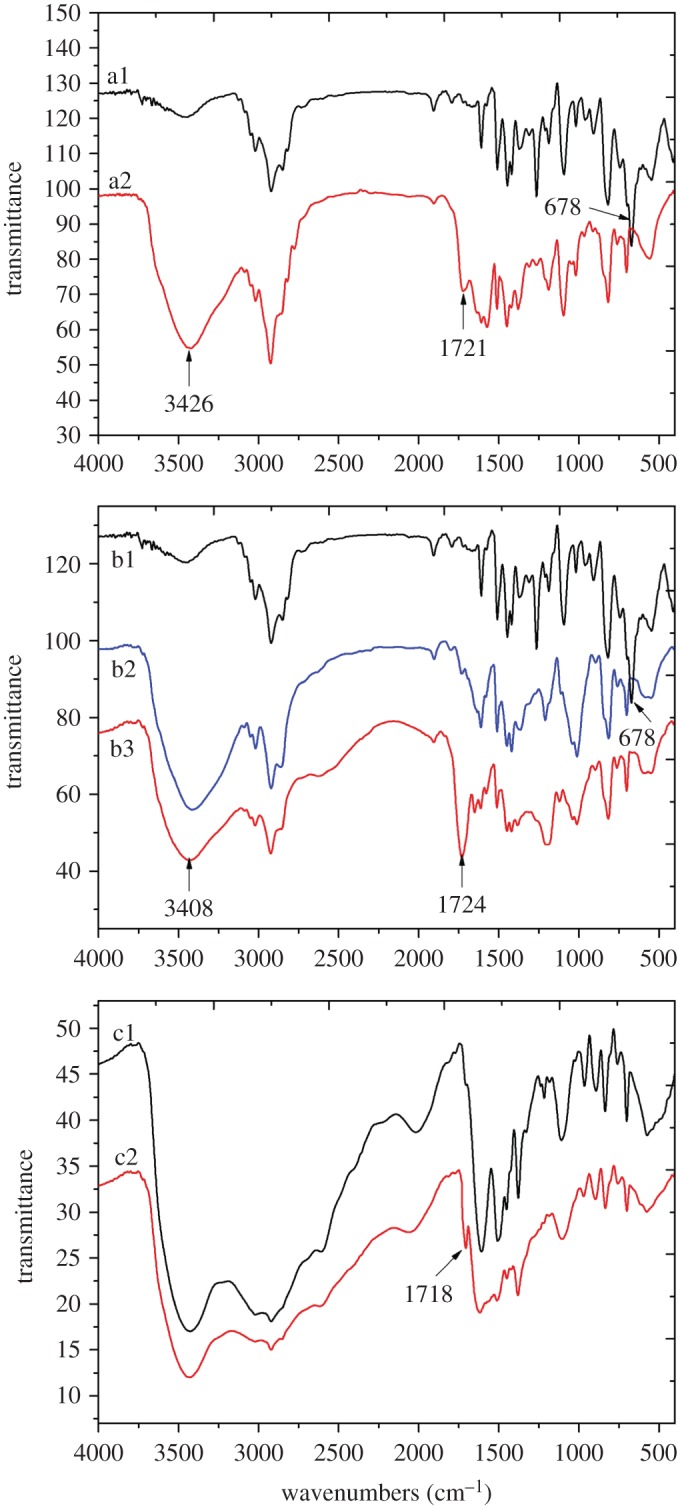
The FTIR spectra of PS-Cl (a1, b1), PS-CA (a2), PS-OH (b2), PS-O-CA (b3), PS-NH2 (c1) and PS-N-CA (c2).